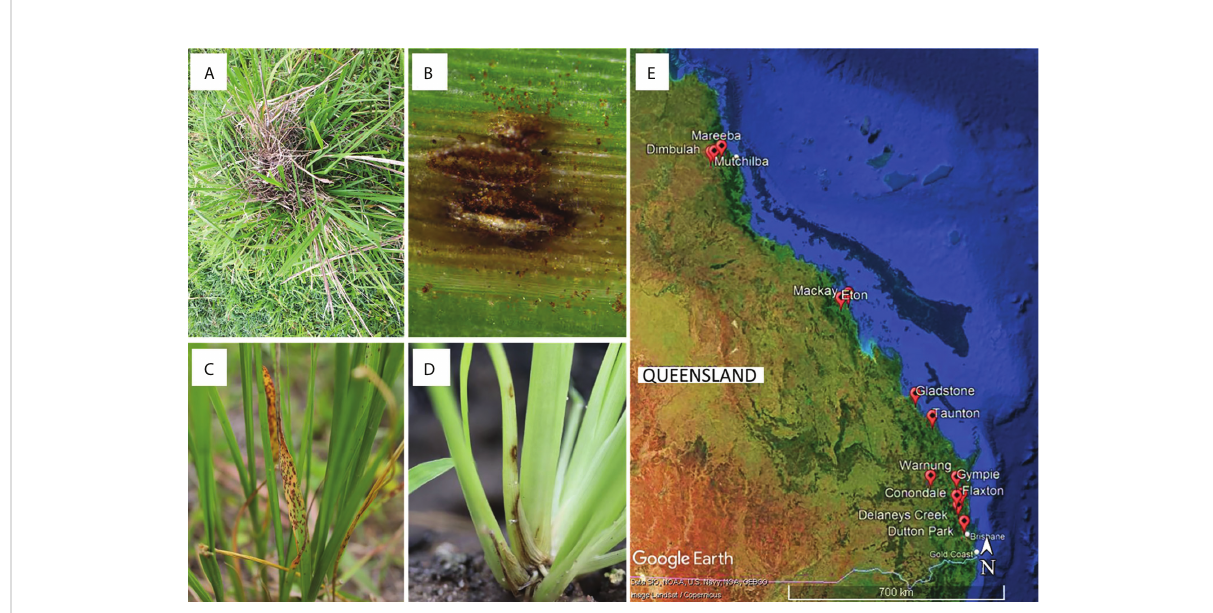
FIGURE 1 (A – D) Examples of disease symptoms on Sporobolus spp. Plants targeted for sampling, and (E) sampling sites for this study in Queensland, Australia generated using Google Earth